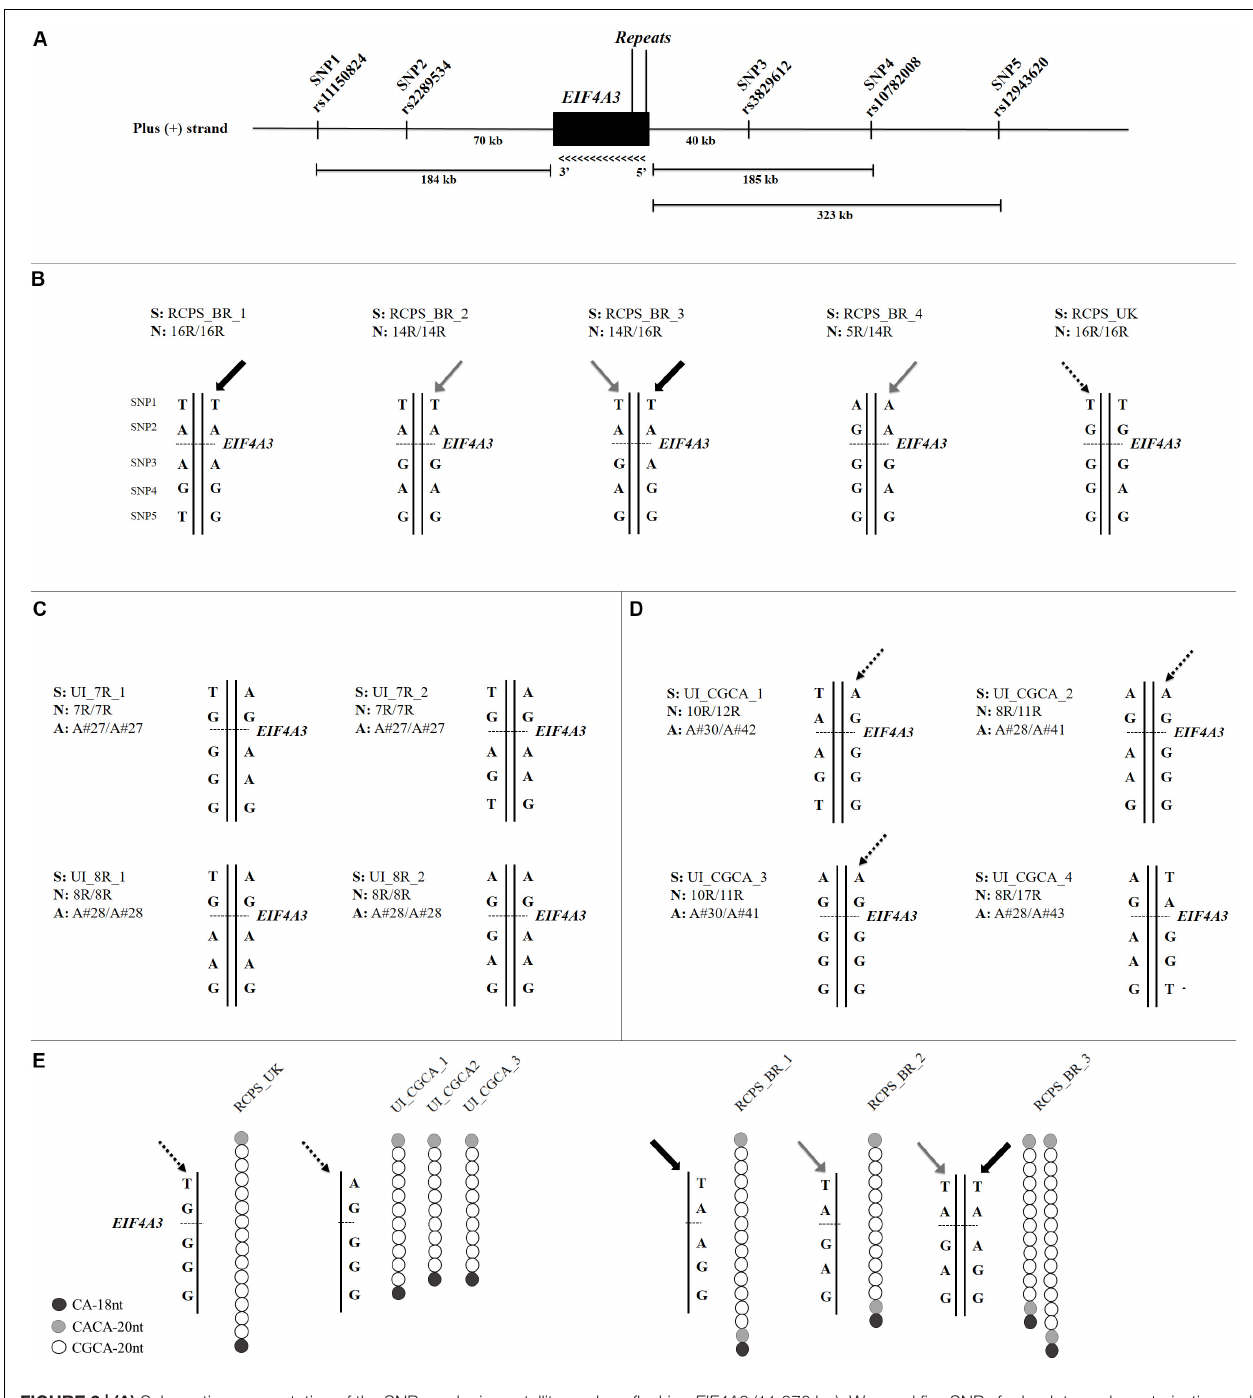
Frontiers in Genetics |